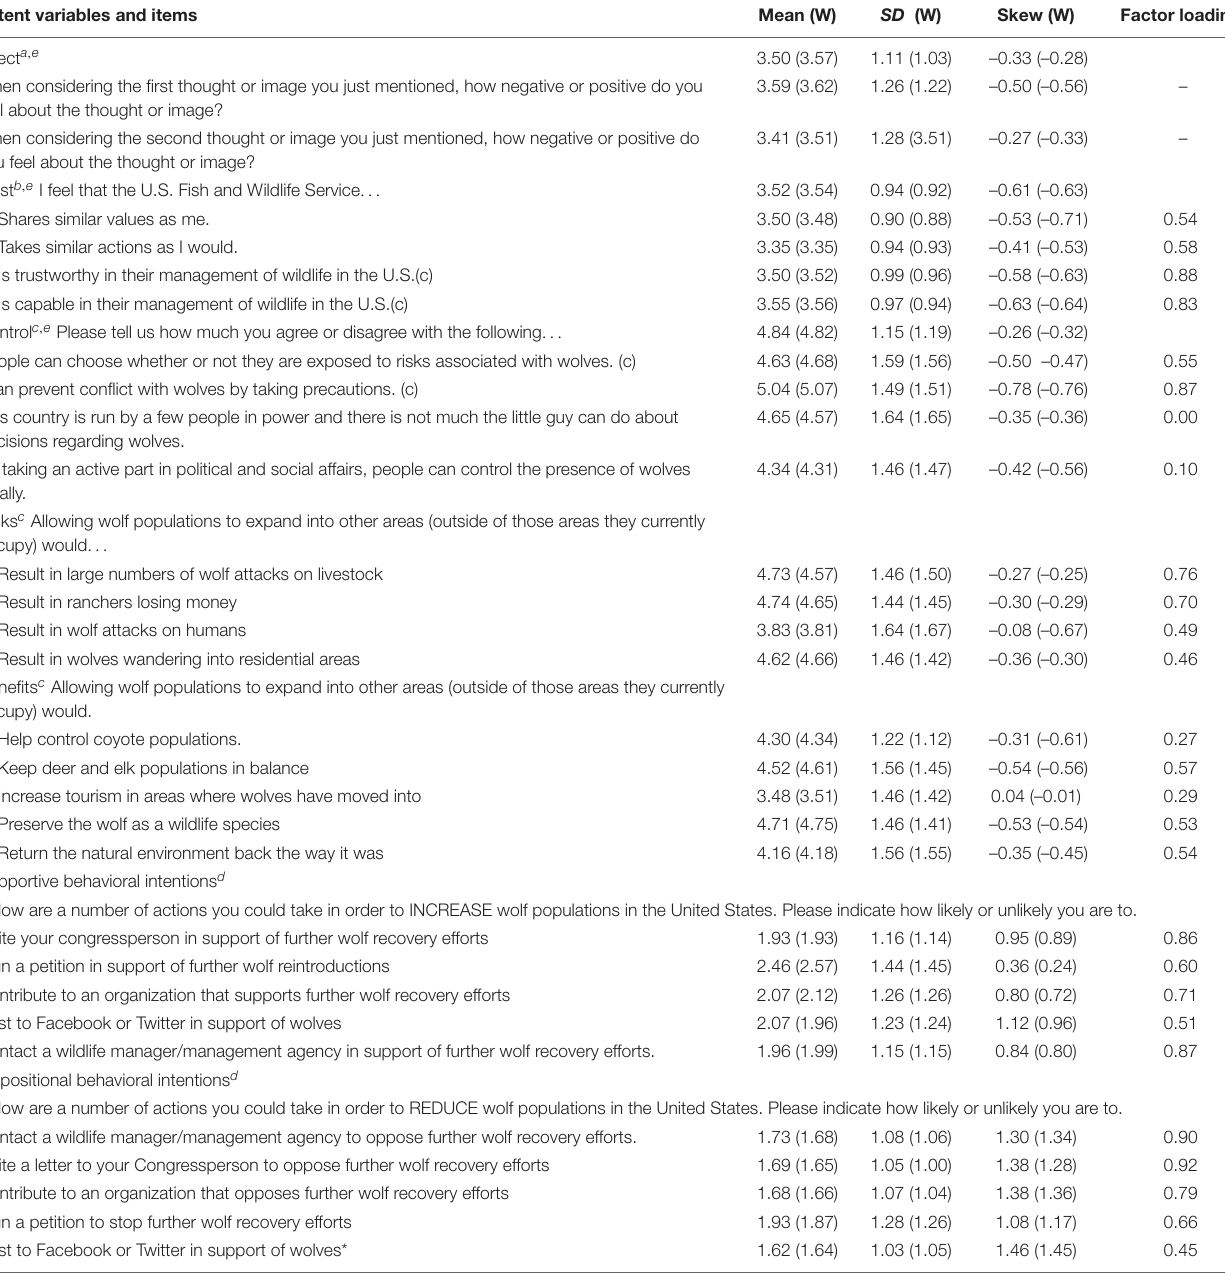
TABLE 1 | Factor loadings, unweighted and weighted descriptive statistics of items used to measure latent model